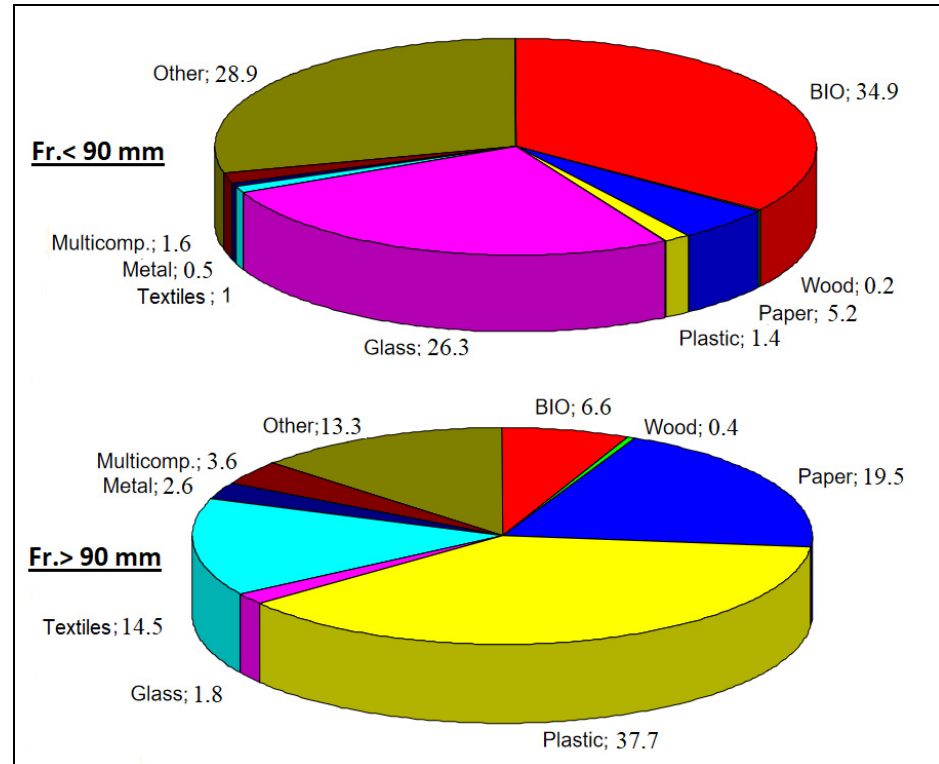
Figure 2. Percentage of waste components in two particle size fractions.